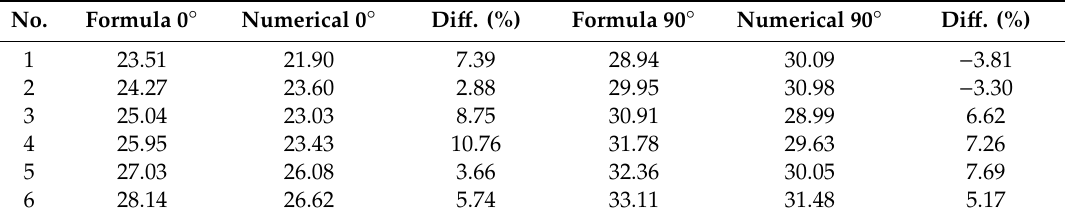
Table 6. Stress intensity factor comparison between empirical formula and finite element